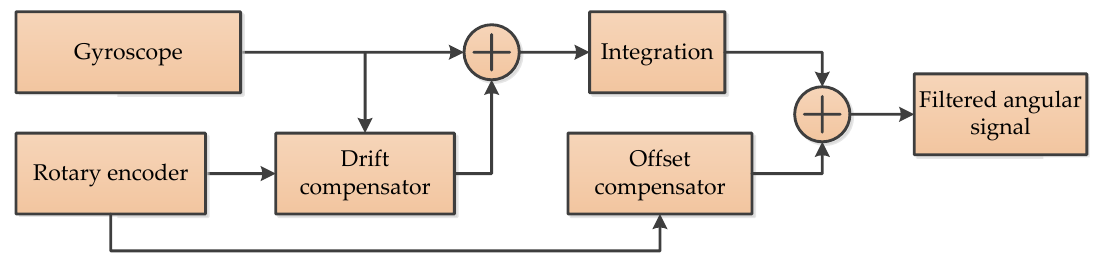
ff set compensator Figure 12. The structure of Drift offset compensator [55]. Figure 12. The structure of Drift offset compensator [55]. Figure 12. The structure of Drift o